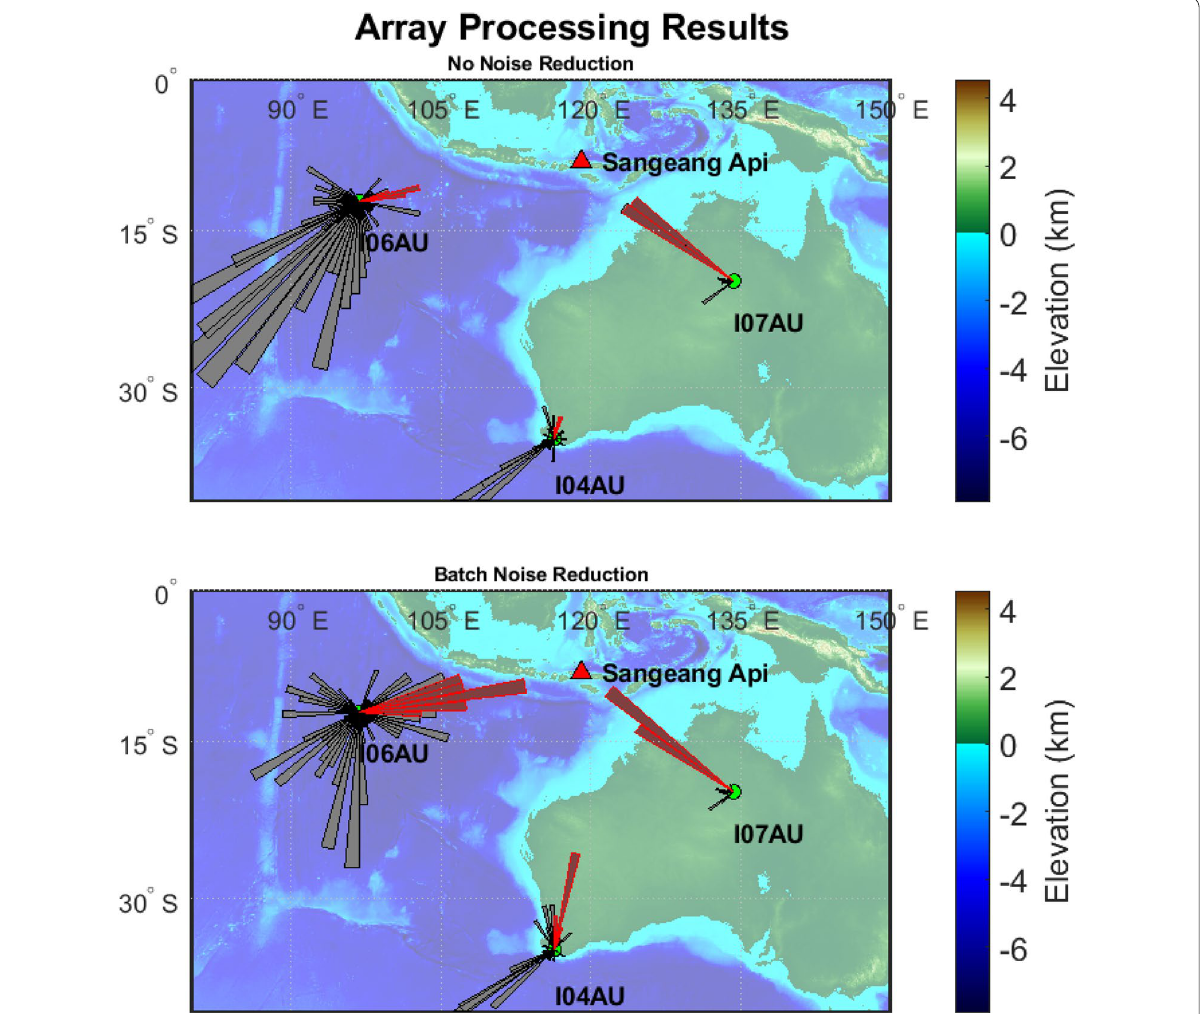
Fig. 4 Map, I07AU, I06AU and I04AU raw on top. Batch station level noise reduction is shown below (performed for all stations), both normalized by station (I07AU has more pixels in total than I06AU). After noise reduction, the back azimuth (shown in red) is now clearly identifiable within the rose